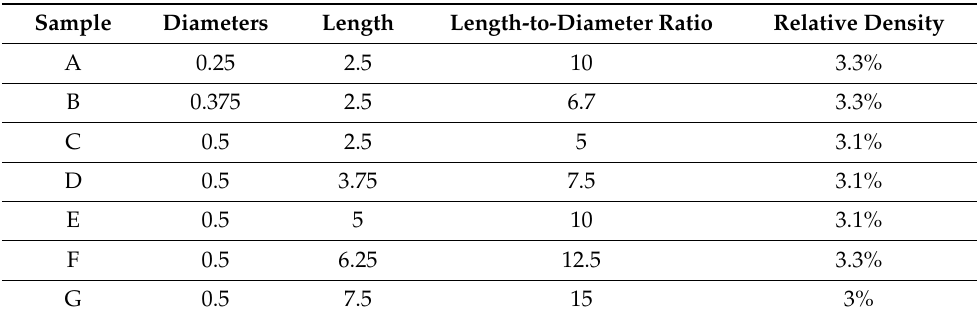
Table 1. Summary of architecture and properties of tested microlattices.